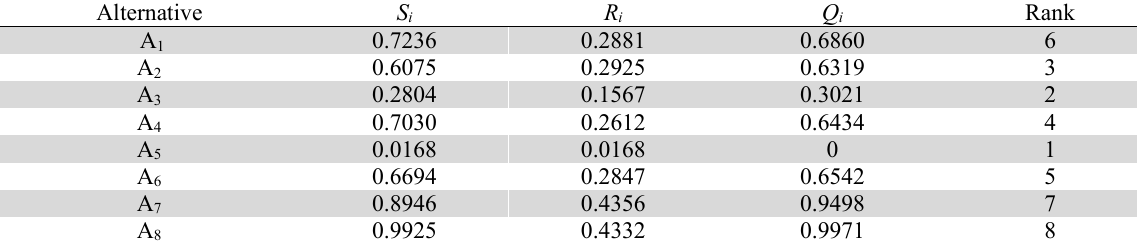
Ranking of material alternatives in VIKOR method